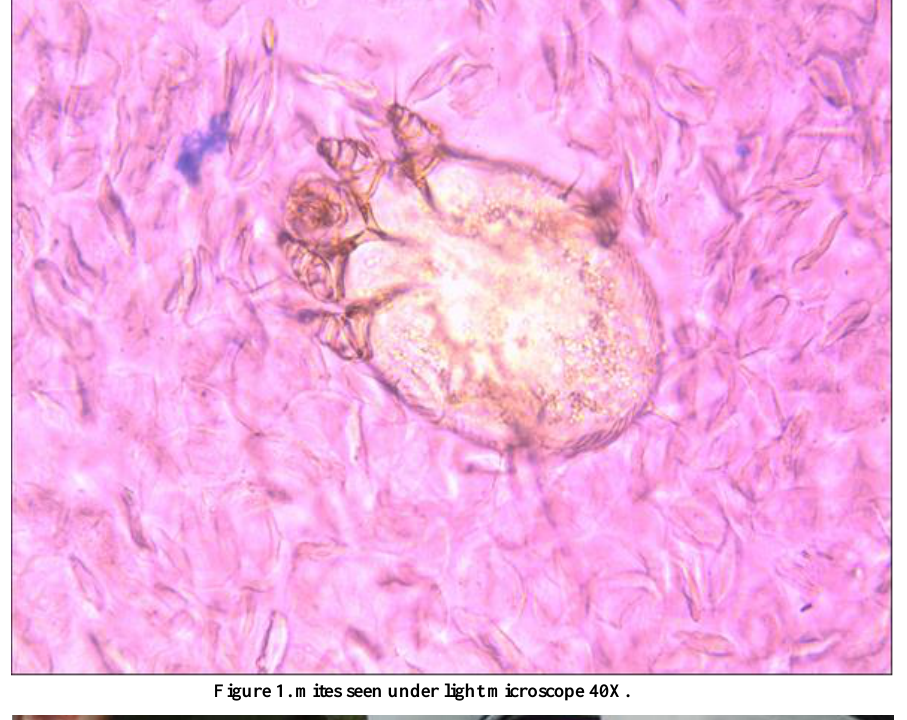
Figure 1. mites seen under light microscope 40X.